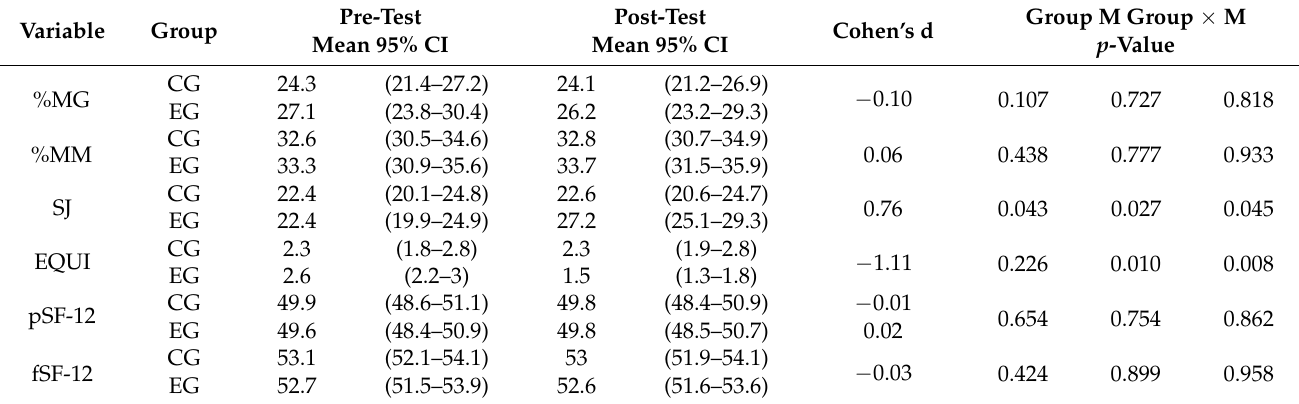
Table 3. Inferential statistics of the 2 × 2 ANOVA test and effect sizes.